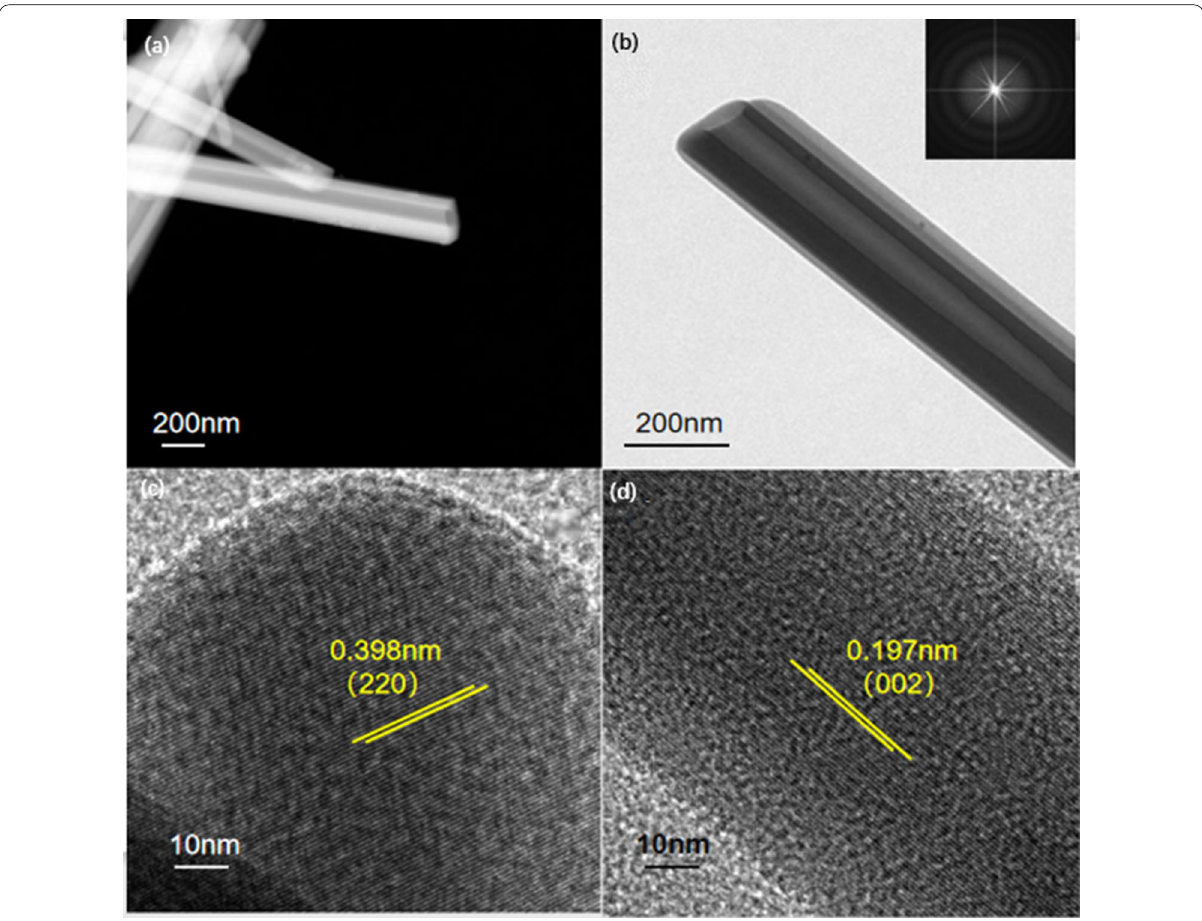
Fig. 3 a , b TEM images of the Bi 2 S 3 nanotubes and c , d HRTEM images of the Bi 2 S 3 nanotubes